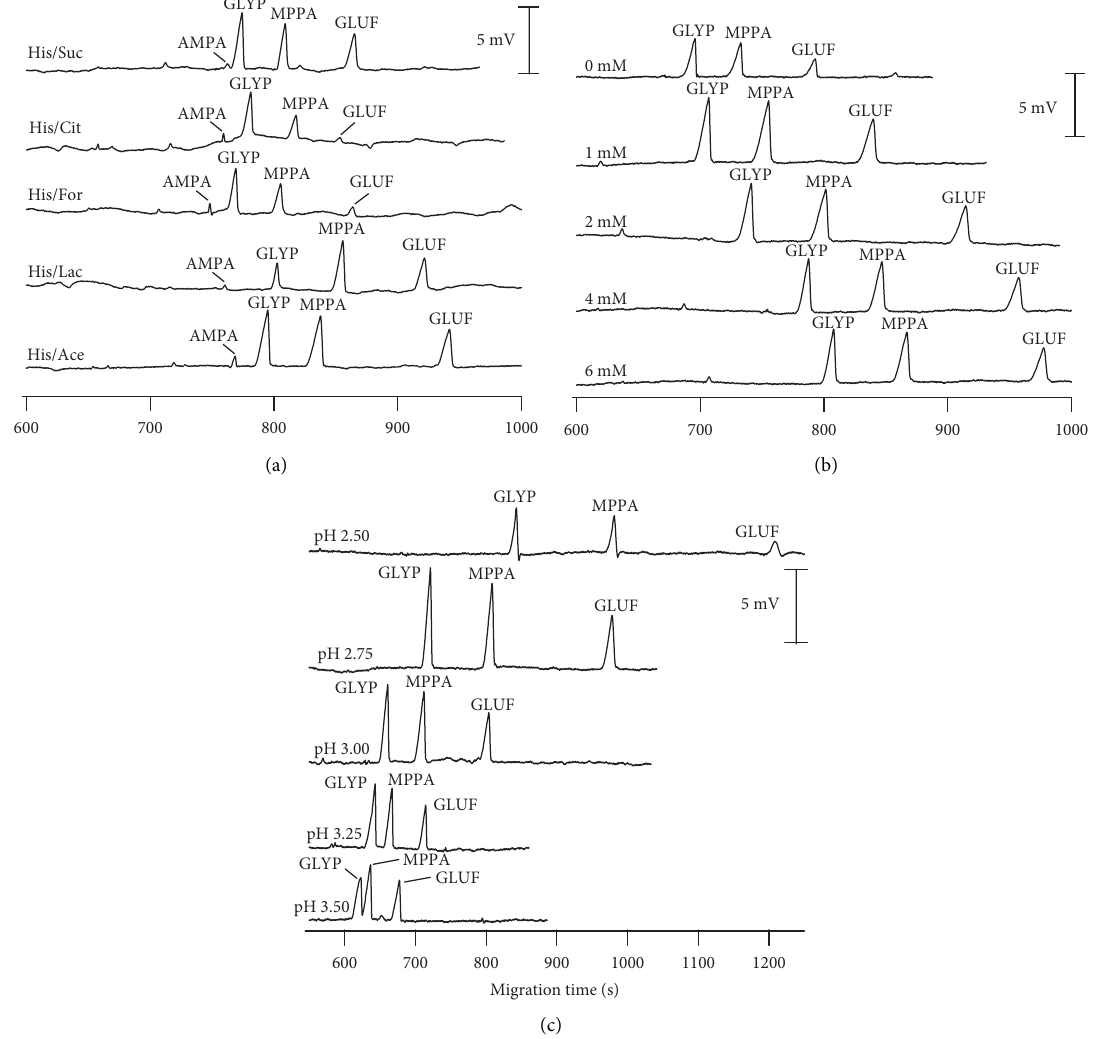
Figure 1: Electropherogram for the optimization of BGE compositions for determination of GLYP, GLUF, and MPPA. CE conditions: voltage: 20 kV from the detection side; uncoated fused silica capillary with ID � 50 µ m, Lt � 70cm, and Leff �